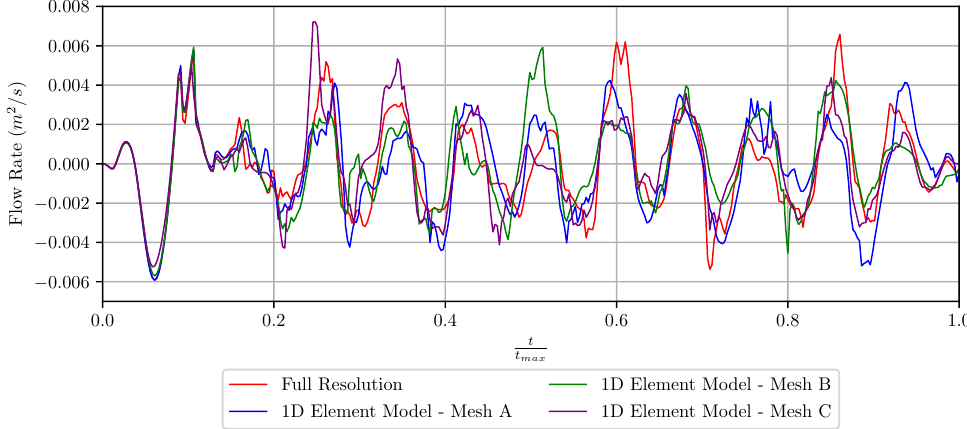
p 2 , of violent slosh test case. −